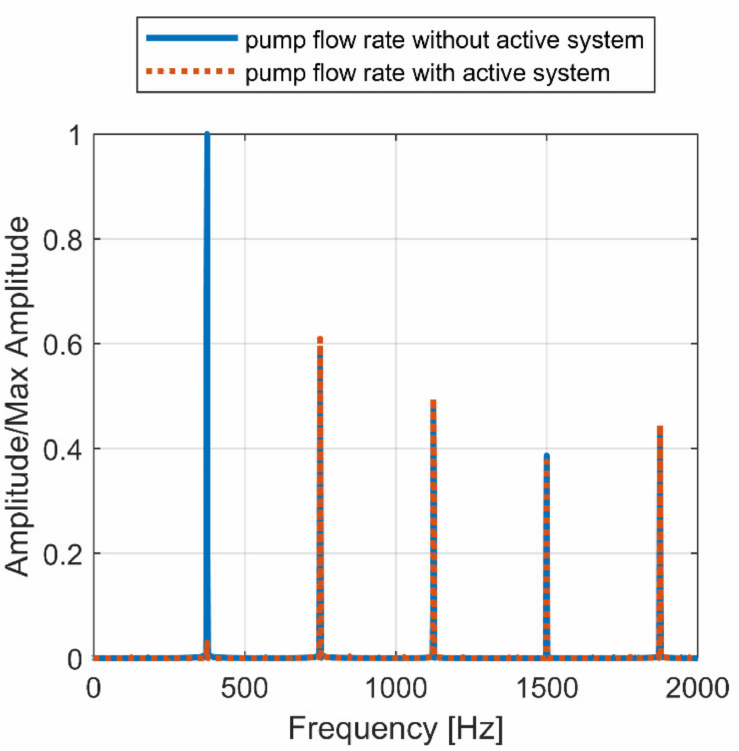
Figure 22. Simulation cycle 1, section 1: flow ripple FFT at 250 bar, 2500 rpm, 100% swash plate inclination.